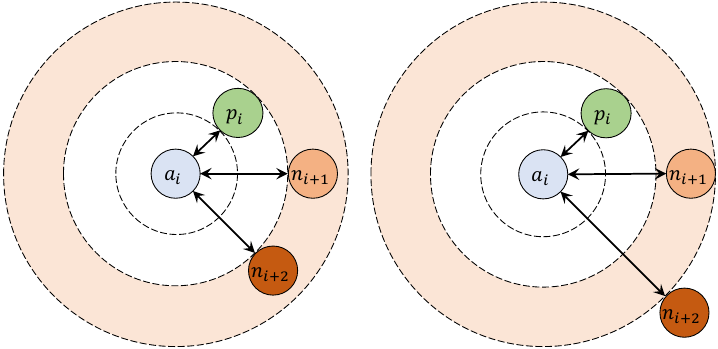
Figure 4: Comparison of two embedding distance calculation methods. Compared with the Euclidean distance (left), the Hybrid Distance (right) introduces a larger distance value when the label distance